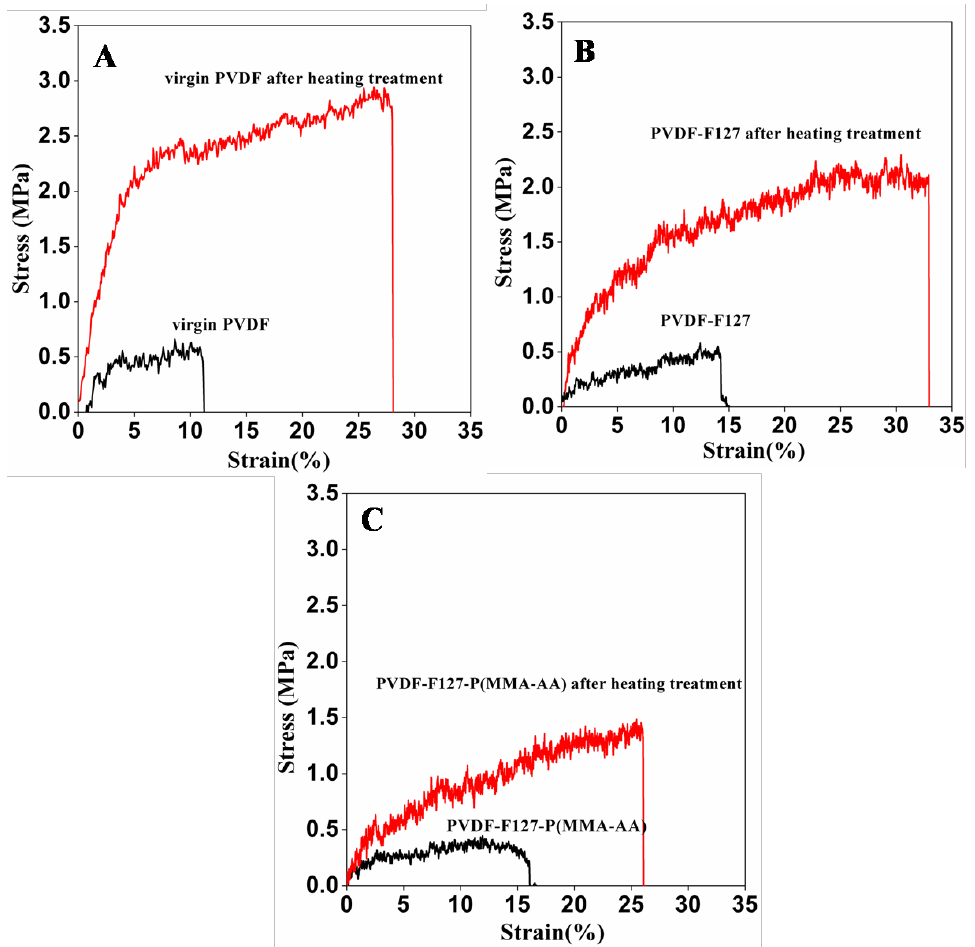
Figure 2. Stress-strain diagrams for PVDF, PVDF-F127, PVDF-F127-P (MMA-AA) membranes. ( A ) PVDF; ( B ) PVDF-F127; ( C ) PVDF-F127-P